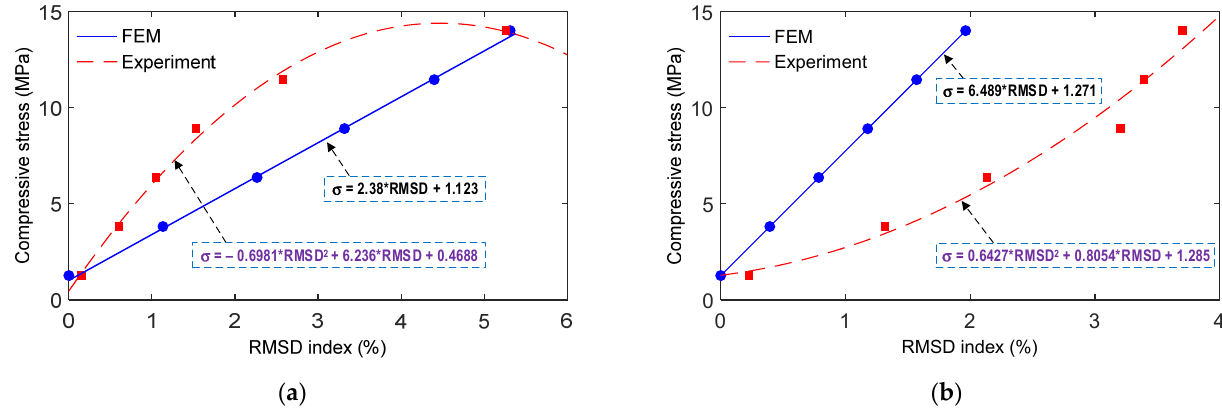
Figure 16. Empirical formulations of measured impedance signatures with respect to applied compressive stresses: ( a ) PZT-embedded smart rebar; ( b ) PZT-embedded smart aggregate.